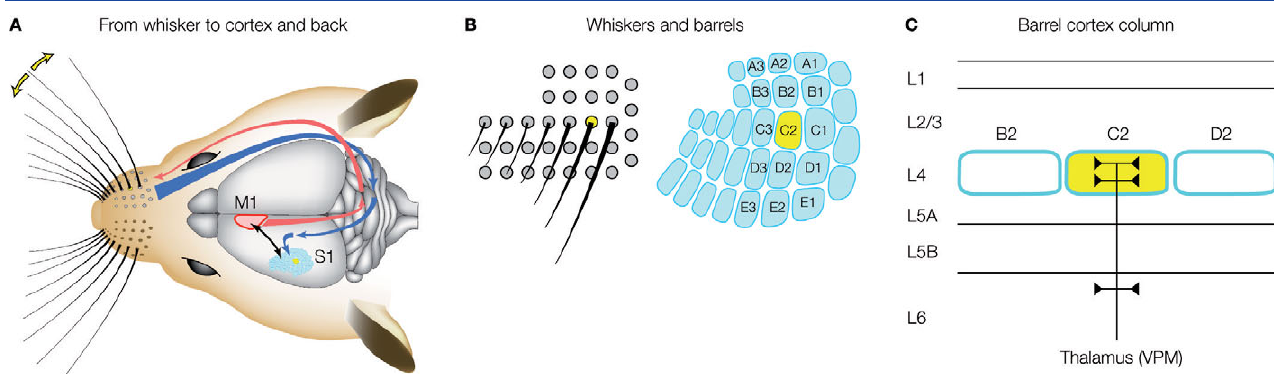
Figure 1 | The barrel cortex. (A) An impressive array of whiskers on the snout of the rodent sends sensory information to the primary somatosensory barrel cortex (S1) via the brainstem and the thalamus. The barrel cortex signals to motor cortex (M1), which in turn regulates whisker movements. Active processing of tactile whisker information therefore appears to be an important feature of this sensory pathway. (B) The layout of the whiskers (left) is precisely matched by the layout of the barrels (right) in primary somatosensory cortex. Mice and rats have the same layout of whiskers and a standard nomenclature has been developed. The C2 whisker and barrel are highlighted in yellow. (C) A barrel column is arranged in different layers. Single whisker sensory information from ventral posterior medial (VPM) thalamus arrives predominantly in a single layer 4 barrel. The supragranular layer 2/3 and the infragranular layers 5/6 are thought to perform integrative functions. Modifi ed and reproduced with permission from Petersen (2007). Copyright from Neuron, Cell